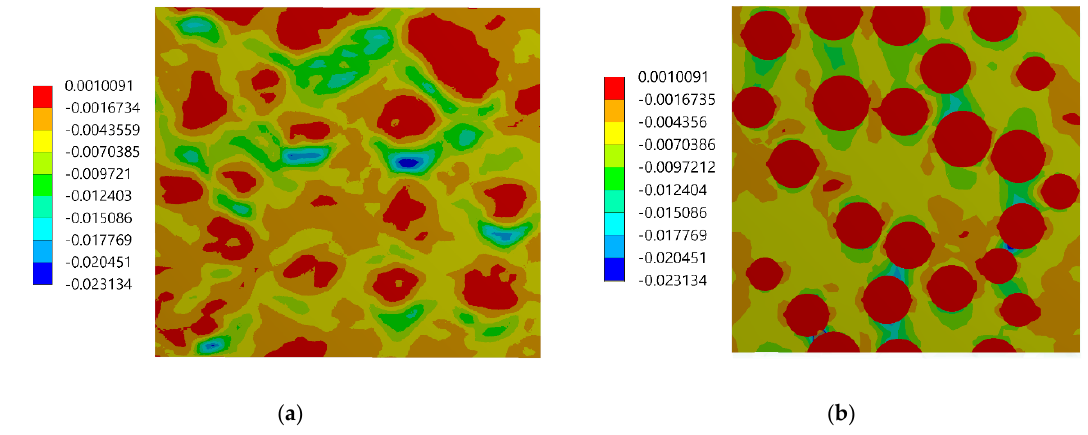
Figure 13. Strain ε xx distributions: ( a ) experimental results (DIC), ( b ) numerical results (FEM).